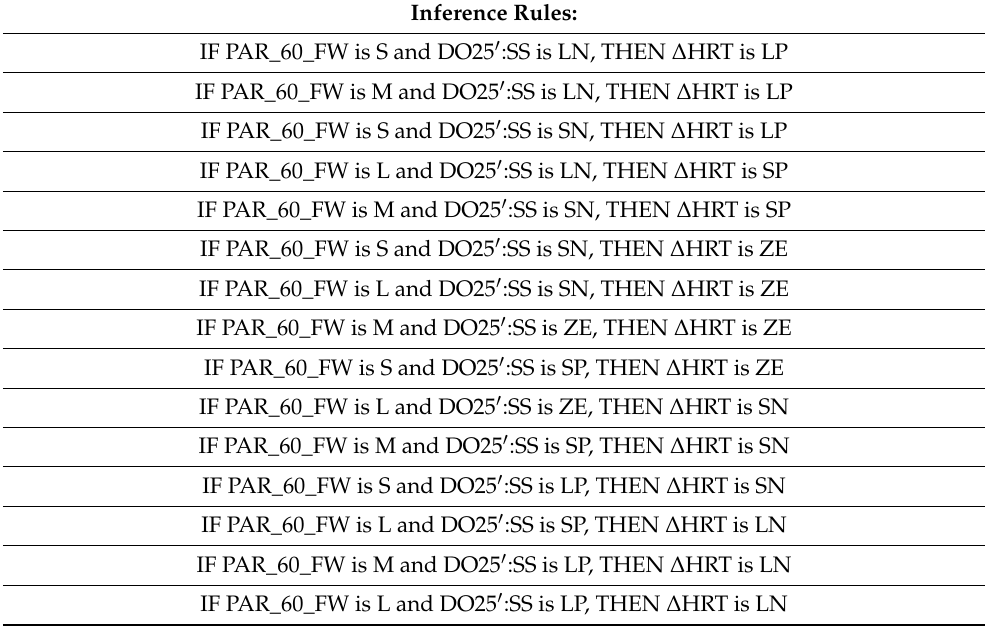
Table 4. Fuzzy control rules hourly HRT